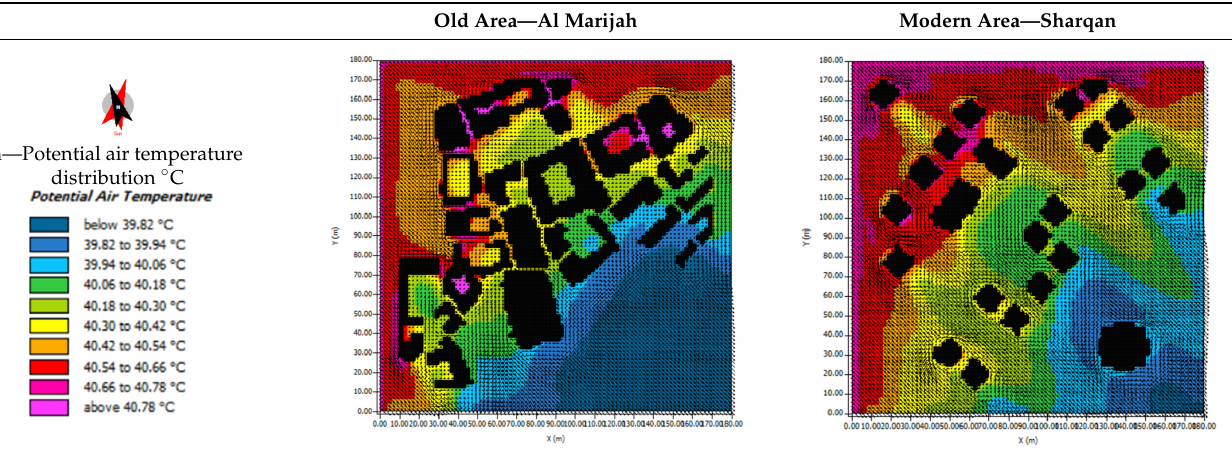
Table 4. The potential air temperature distribution and PMV on both case studies (old and new) at height 1.8 m on 21st of August.